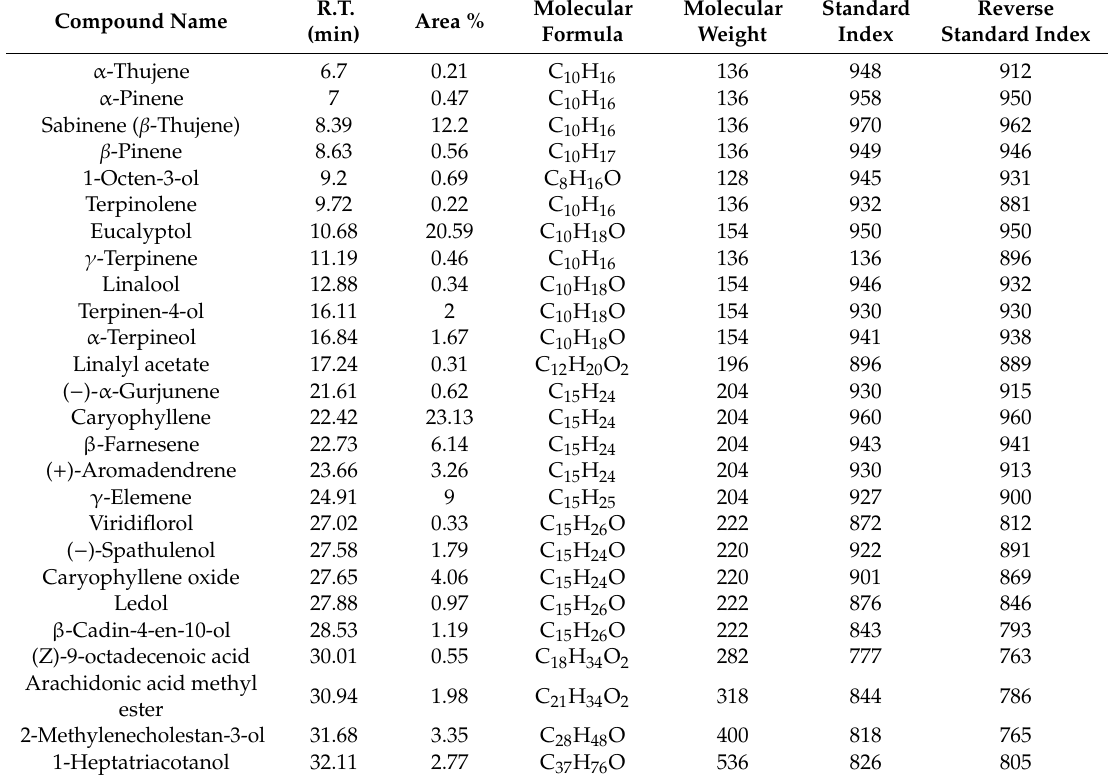
Table 4. Chemical composition of the essential oil from Vitex agnus-castus leaves.